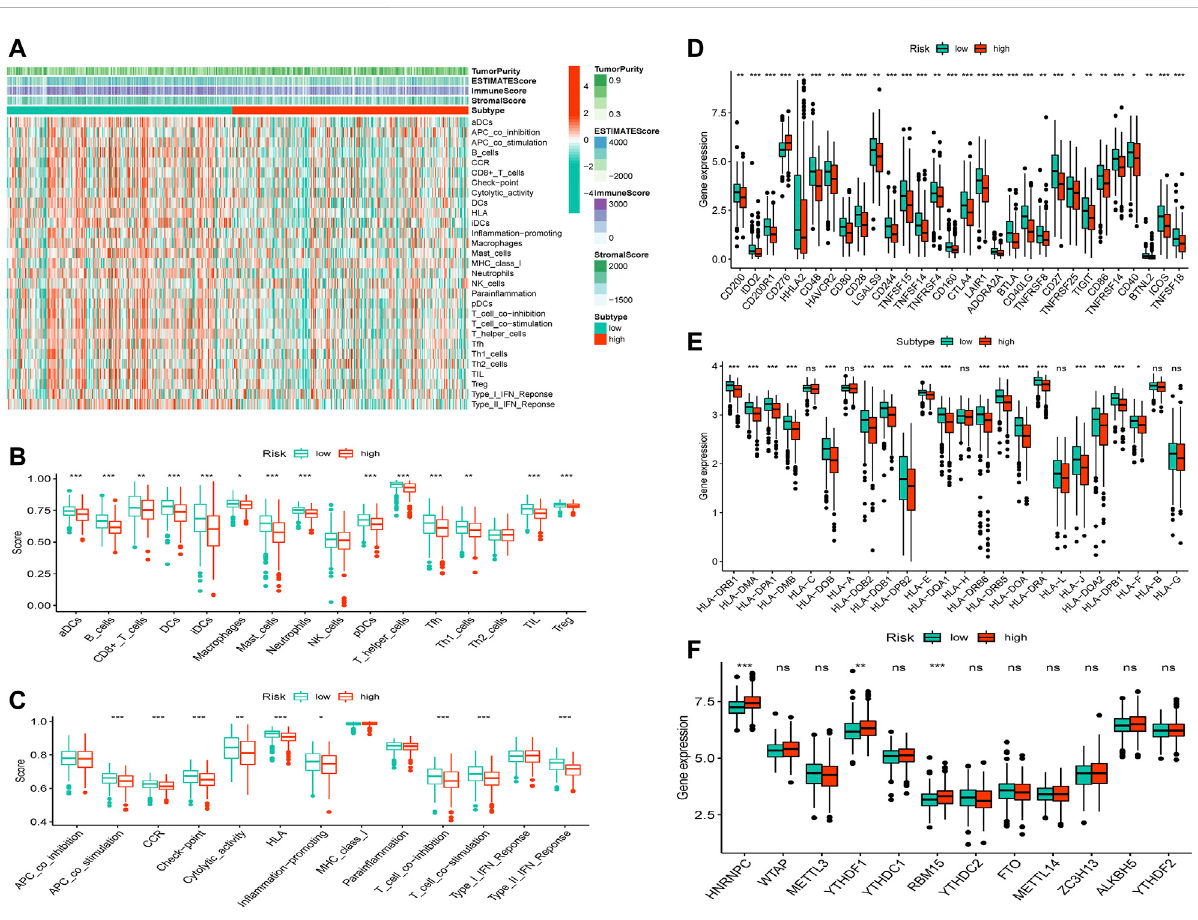
FIGURE 6 TME, checkpoint, HLA, and m6A methylation analysis in LUAD. (A) The heatmap of immune cells and estimate, immune, and stromal scores between the high-risk and low-risk groups. (B) The box plots of immune cells between the high-risk and low-risk groups. (C) The box plots of immune-related pathways between the high-risk and low-risk groups. (D) The box plots of checkpoint-related genes between the high-risk and low-risk groups. (E) The box plots of HLA-related genes between the high-risk and low-risk groups. (F) The box plots of m6A methylation- related genes between the high-risk and low-risk groups.* p < 0.05,** p < 0.01, *** p <